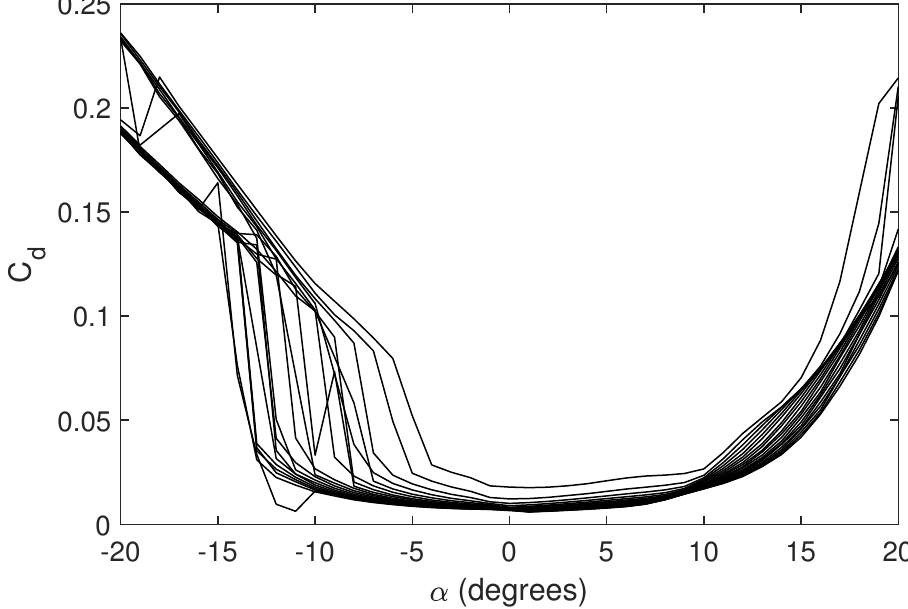
Figure A2. Drag coefficient from XFOIL at different Reynolds numbers ranging from 2 × 10 4 to 1 × 10 6